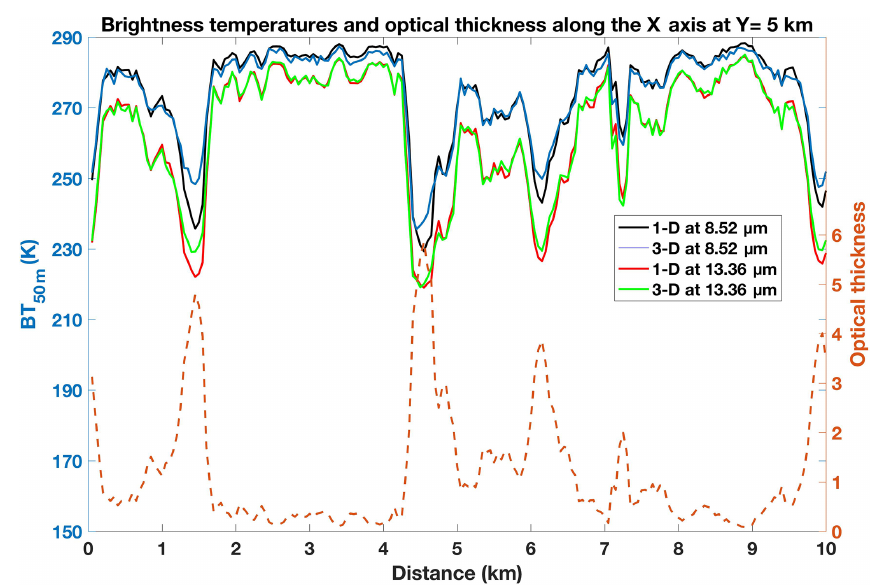
Figure 6. Optical thickness and brightness temperatures at 50m spatial resolution computed in 3-D and 1-D at 8.52 and 13.36µm along a line of constant y axis coordinate (5km) in the optical thickness field of Fig.